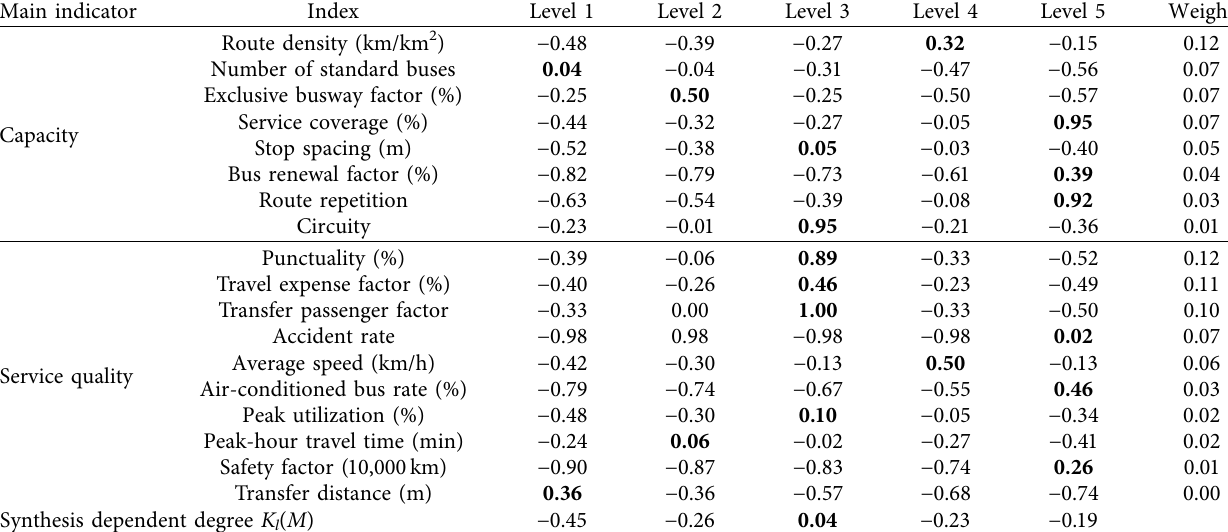
Table 5: Dependent degrees associated with each index.